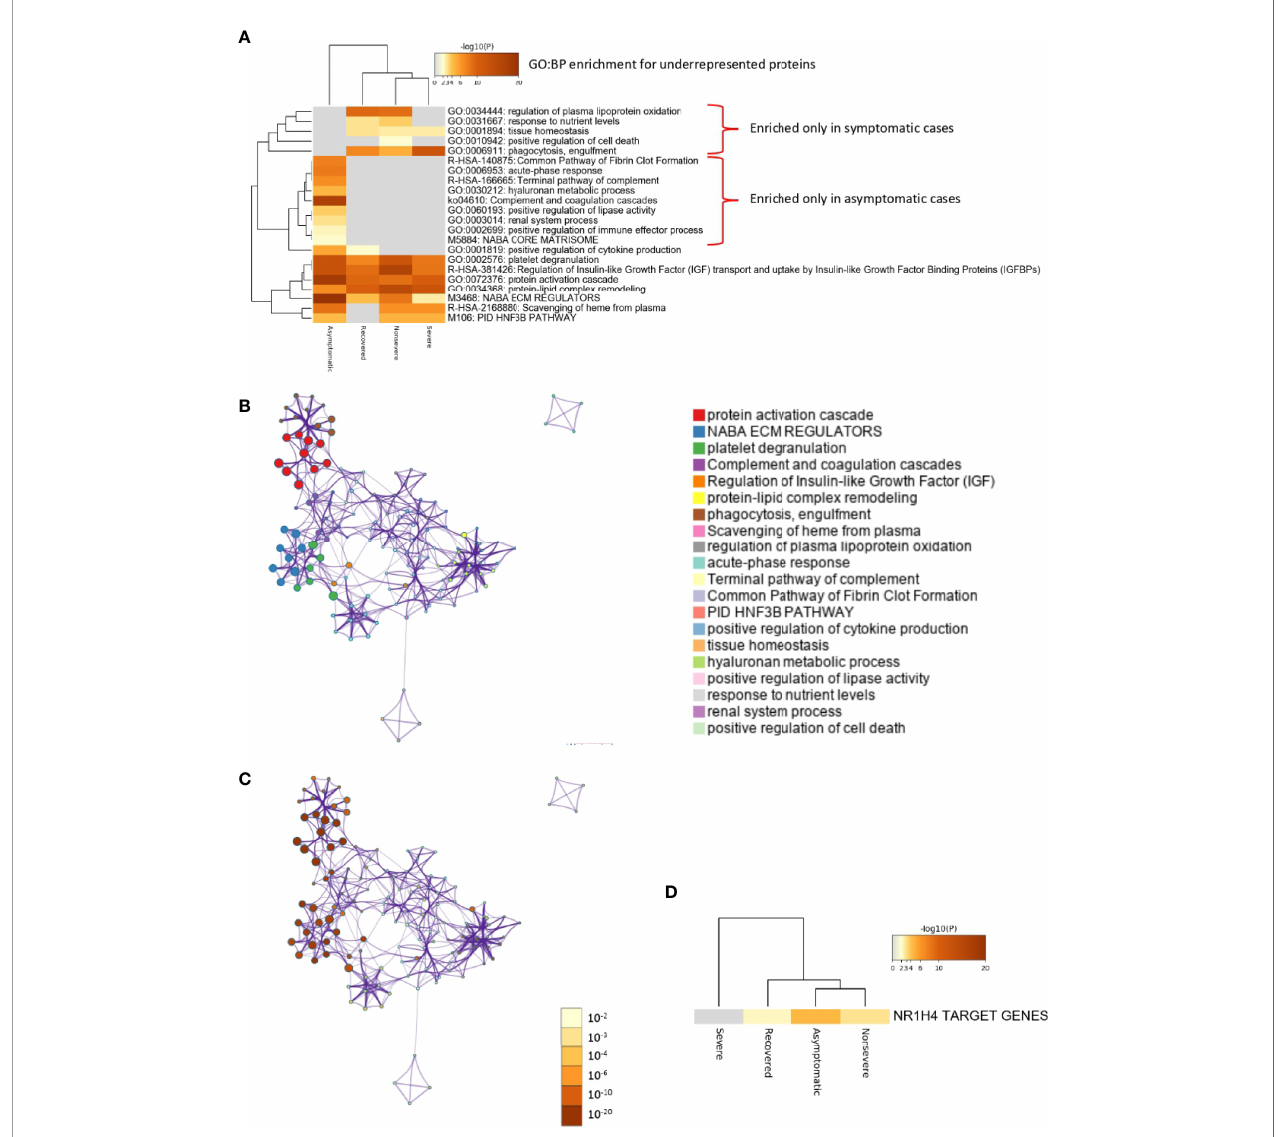
FIGURE 6 | Enrichment ontology clusters for differentially underrepresented proteins in sera from COVID-19 cases. (A) Statistically enriched terms (GO/KEGG biological processes; GO : BP). Accumulative hypergeometric p -values and enrichment factors were calculated and used for fi ltering. Remaining signi fi cant terms were then hierarchically clustered into a tree based on Kappa-statistical similarities among their protein memberships (as used in DAVID Bioinformatics Resources 6.8; https://david.ncifcrf.gov). A 0.3 Kappa score was applied as the threshold to cast the tree into term clusters. The term with the best p -value within each cluster was selected as its representative term and displayed in a dendrogram. The heatmap cells are colored by their p -values; white cells indicate the lack of enrichment for that term in the corresponding gene list. BPs enriched only in symptomatic or asymptomatic cases are shown. (B) Network of enriched terms. We selected a subset of representative terms from the full cluster and convert them into a network layout. More speci fi cally, each term is represented by a circle node, where its size is proportional to the number of input genes that fall into that term, and its color represents its cluster identity (i.e., nodes of the same color belong to the same cluster). Terms with a similarity score > 0.3 are linked by an edge (the thickness of the edge represents the similarity score). The network is visualized with Cytoscape (v3.1.2) with “ force-directed ” layout and with edge bundled for clarity. One term from each cluster is selected to have its term description shown as label. (C) Network of enriched terms colored by p -value. The same enrichment network has its nodes colored by p -value, as shown in the legend. The darker the color, the more statistically signi fi cant the node is (see legend for p -value ranges). (D) Quality control and association analysis. Protein lists were identi fi ed in the ontology categories Transcription_Factor_Targets. All genes in the genome were used as the enrichment background. Terms with a p -value < 0.01, a minimum count of 3, and an enrichment factor (ratio between the observed counts and the counts expected by chance) > 1.5 were collected and grouped into clusters. The algorithm used here is the same as that used in the other enrichment